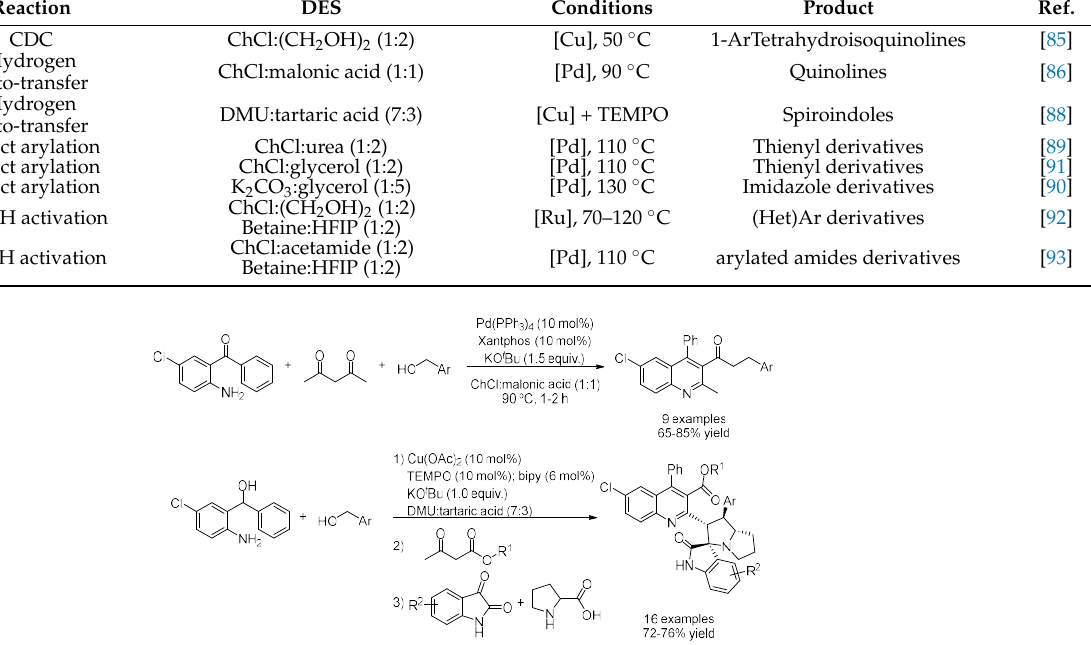
Table 4. Selected examples of C-H functionalizations catalyzed by transition metals in DESs. Figure 29. Cross-dehydrogenative coupling of 1,2,3,4-tetrahydroisoquinolines.